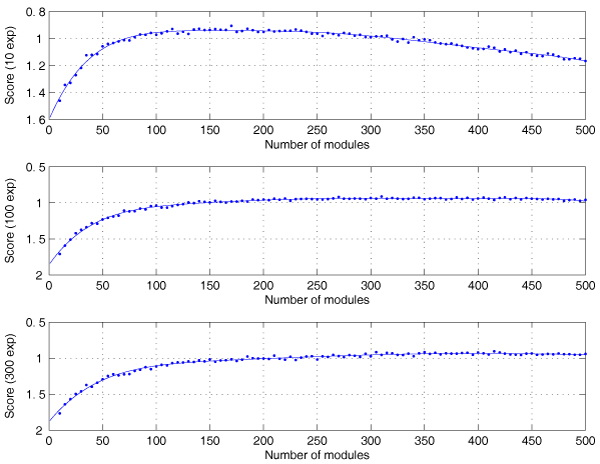
Bayesian score as a function of the number of modules and experiments. Bayesian score as a function of the number of modules for data sets with 10, 100 and 300 experiments (top to bottom). The score is normalized by the number of genes times the number of experiments. The curves are least squares fits of the data to a linear non-polynomial model of the form a0+∑k=1nakxk−1e−x/500
MathType@MTEF@5@5@+=feaafiart1ev1aaatCvAUfKttLearuWrP9MDH5MBPbIqV92AaeXatLxBI9gBaebbnrfifHhDYfgasaacH8akY=wiFfYdH8Gipec8Eeeu0xXdbba9frFj0=OqFfea0dXdd9vqai=hGuQ8kuc9pgc9s8qqaq=dirpe0xb9q8qiLsFr0=vr0=vr0dc8meaabaqaciaacaGaaeqabaqabeGadaaakeaacqWGHbqydaWgaaWcbaGaeGimaadabeaakiabgUcaRmaaqadabaGaemyyae2aaSbaaSqaaiabdUgaRbqabaGccqWG4baEdaahaaWcbeqaaiabdUgaRjabgkHiTiabigdaXaaakiabdwgaLnaaCaaaleqabaGaeyOeI0IaemiEaGNaei4la8IaeGynauJaeGimaaJaeGimaadaaaqaaiabdUgaRjabg2da9iabigdaXaqaaiabd6gaUbqdcqGHris5aaaa@461A@ with x the number of modules and n = 6.